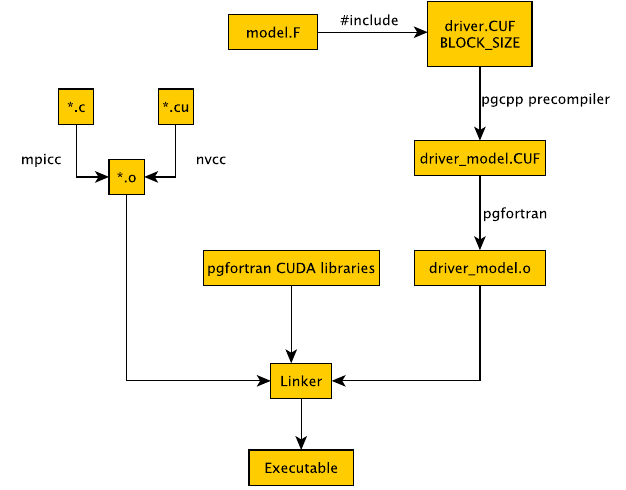
Fig. 2. Compilation and linking process of the spin-up for usage on the GPU.